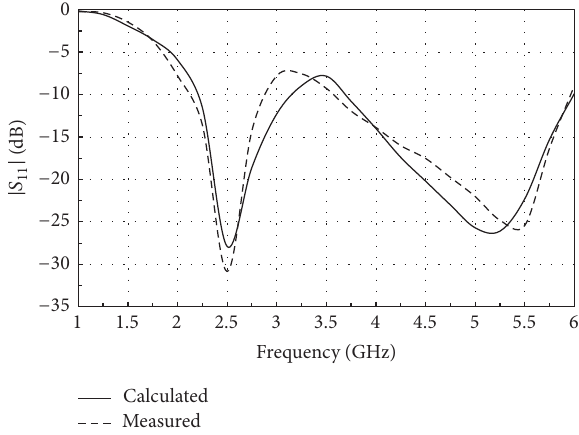
Figure 14: Calculated and measured results of |𝑆 11 | .